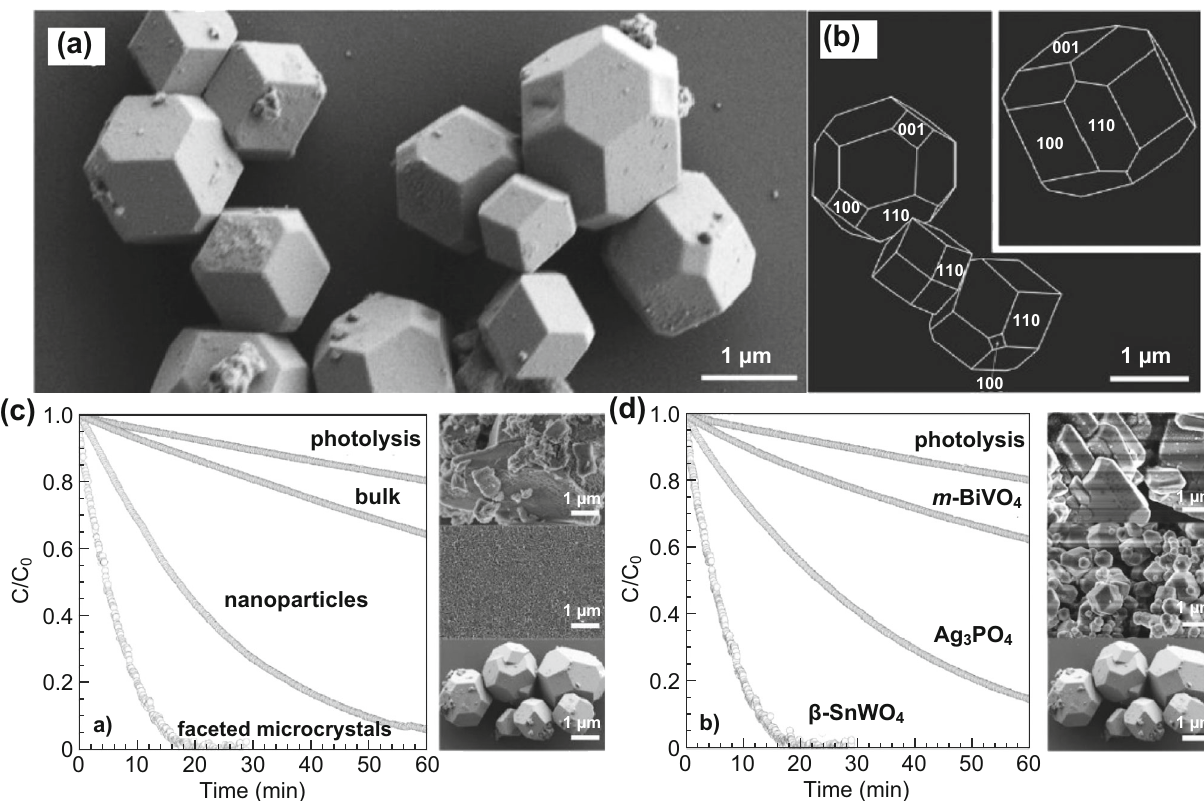
Fig. 11 a , b FESEM images of faceted b -SnWO 4 microcrystals. c, d FESEM images and photocatalytic activities for the degradation of MB over faceted b